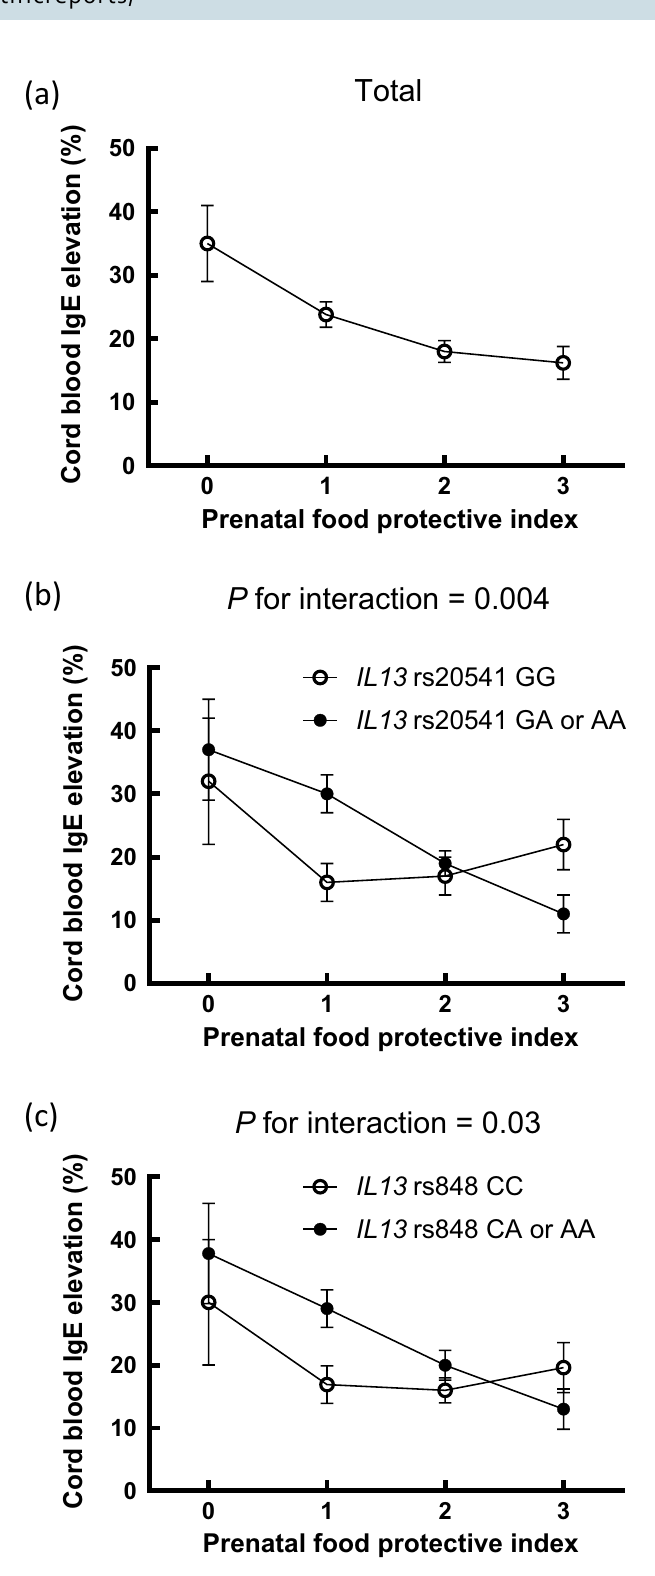
Figure 1. Relations between prenatal food protective index (i.e., any fairly lean fish, daily fruit, and absence of any canned fish) and cord blood total IgE elevation in ( a ) total study sample, ( b ) newborns with IL13 rs20541 GG genotype or GA or AA genotype, and ( c ) newborns with IL13 rs848 CC genotype or CA or AA genotype. Data represent proportions ± standard error of the proportion. P for interactions are the P -values between the prenatal food protective index and IL13 rs20541 ( b ) and between the prenatal food protective index and IL13 rs848 ( c